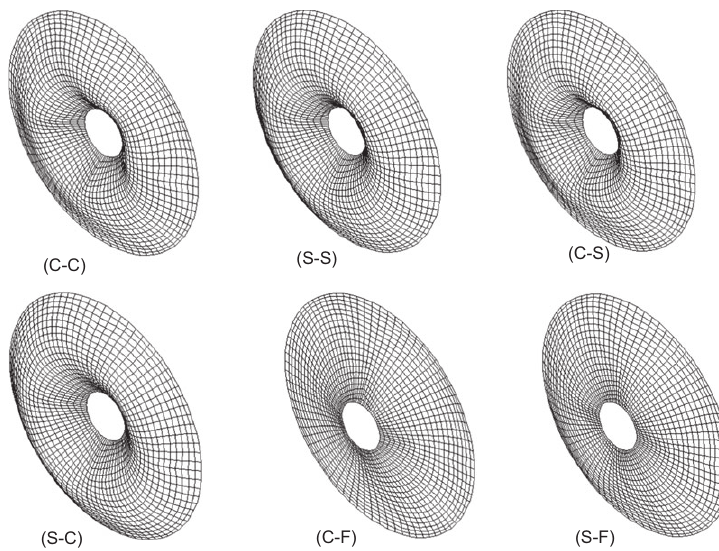
Figure 4 Mode shapes for the laminated annular circular plates (a/b = 0.2).